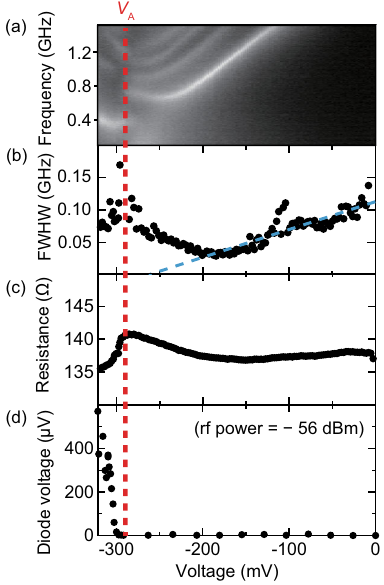
Fig. 5 In fl uence of spin-torque auto-oscillation. a Magni fi ed graph of Fig. 4b. b – d Bias-voltage dependence of ( b ) full width at half maximum (FWHM), ( c ) resistance, and ( d ) diode voltage. The dashed red line is the threshold voltage V A associated with the diode effect. The dashed blue line is the linear fi tting of the FWHM in the range of − 180 to − 10 mV; its horizontal intercept corresponds to the threshold voltage of spin-torque